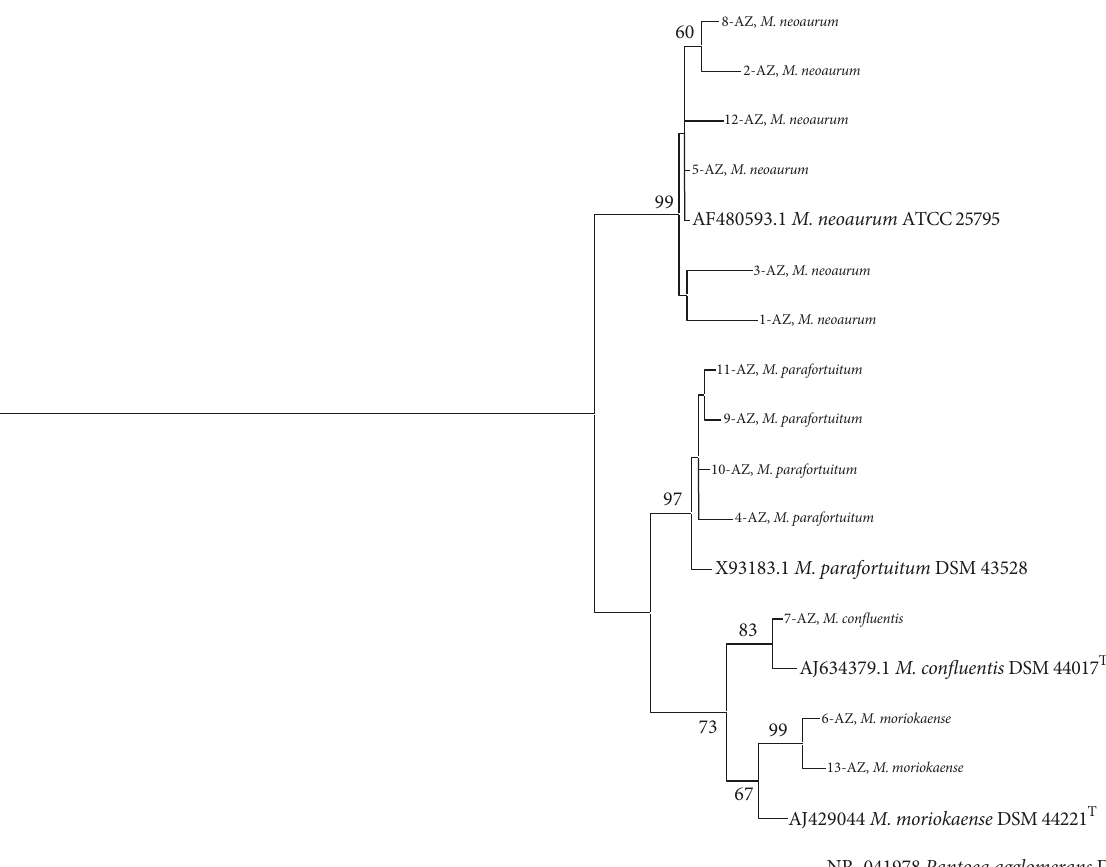
Figure 1: Phylogenetic tree constructed by comparing the 16S rRNA gene sequences from the isolated and reference strains.